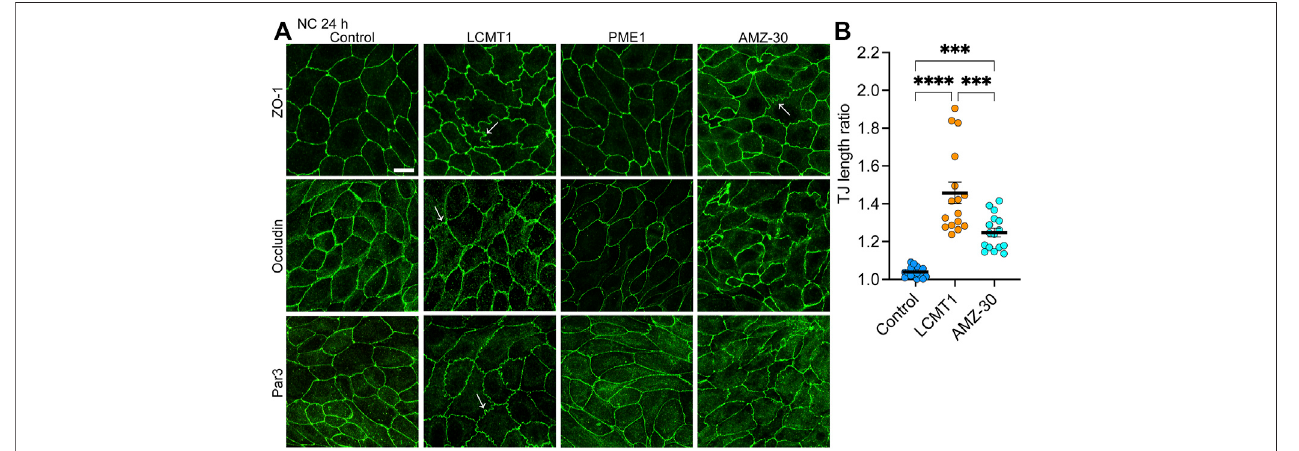
FIGURE 3 | Overexpression of LCMT1 and inhibition of PME1 induce TJ ruf fl ing in MDCK cells. (A) Comparative distribution of ZO-1, occludin and Par3 in control MDCK, MDCK-LCMT1, and MDCK-PME1 cells cultured for 24 h in NC medium. A subset of control cells was incubated in the presence of 1 μ M AMZ-30 (AMZ-30). Arrows indicate examples of ruf fl ed TJs. Representative images from three separate experiments are shown. Scale bar = 10 μ m. (B) Quanti fi cation of TJ ruf fl ing was performedbydividingtheactualjunctionlengthbythedistancebetweentricellularjunctions.Data(mean±SEM)wereappraisedusingone-wayANOVA(F=35,26;